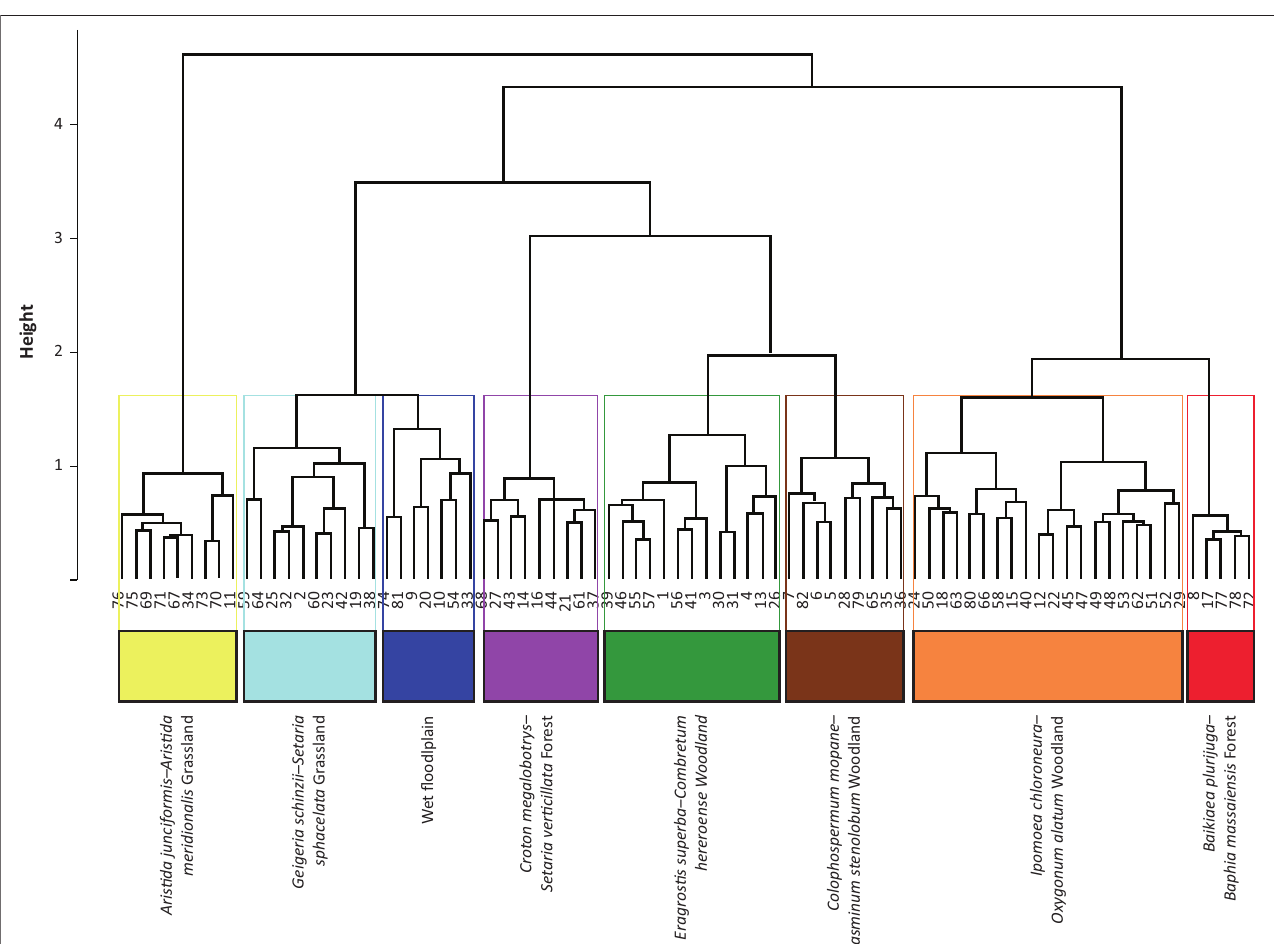
FIGURE 1-A4: Hierarchical clustering of the plant inventory plots ( N = 82) in the Chobe Enclave based on the Bray-Curtis distance and the Ward’s minimum variance